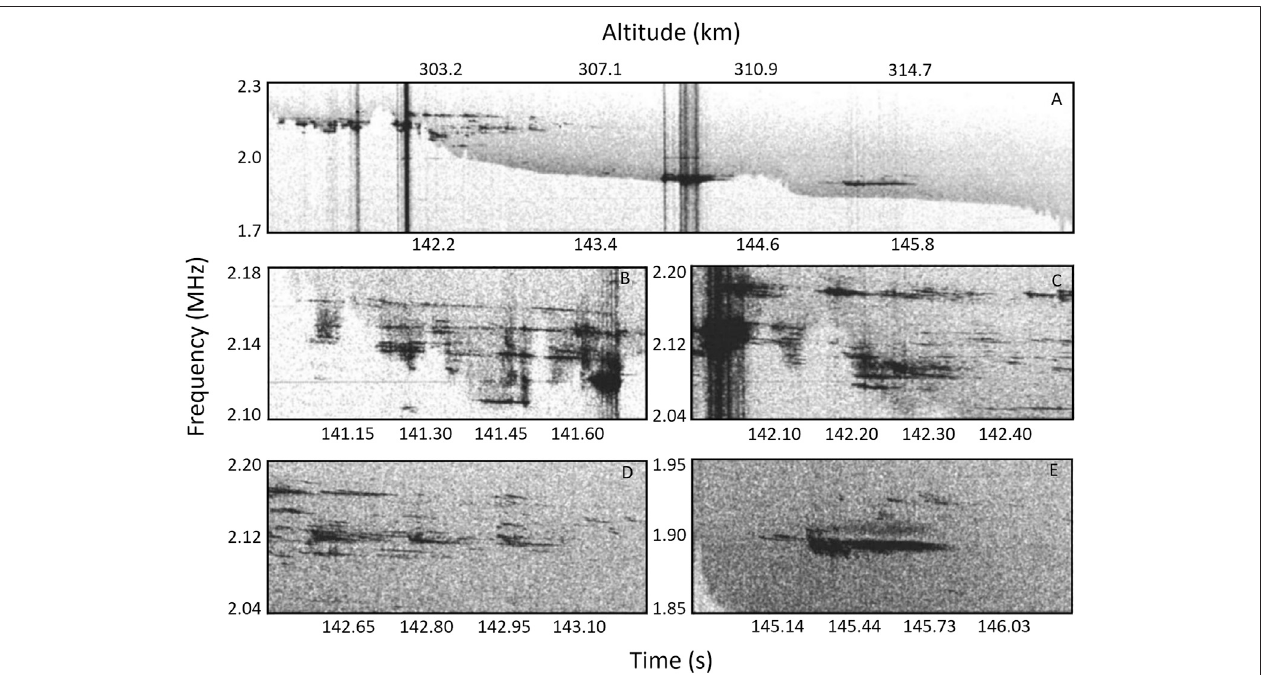
FIGURE4| AdaptedfromMcAdamsandLaBelle(1999):Spectrogramsofelectric fi eldmeasuredwitha30-cmdouble-probeantennaat ∼ 310 kmaltitudewiththe PHAZE-2 sounding rocket. Top panel: overview spectrogram showing Langmuir emissions at and just above the plasma frequency, associated with density structures. Bottom panels: zoomed-in spectrograms showing the detailed structure of the Langmuir waves.